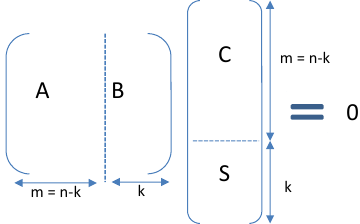
Figure 3. Relation between parity check matrix and generated